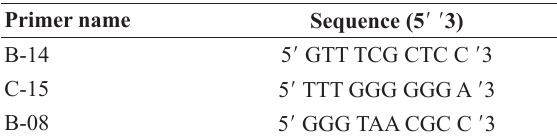
The random primer names and sequences used for RAPD